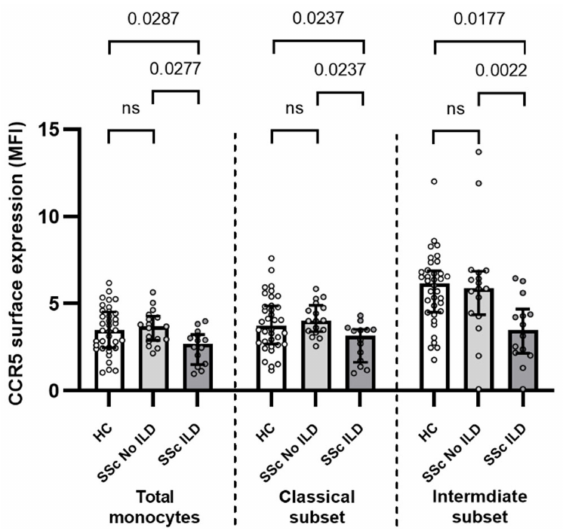
Figure 4. CCR5 surface expression in total monocytes, classical, and intermediate subsets is signif- icantly lower in SSc patients with ILD compared with SSc patients without ILD and the healthy controls. HC—healthy controls; ILD—interstitial lung disease; SSc—systemic